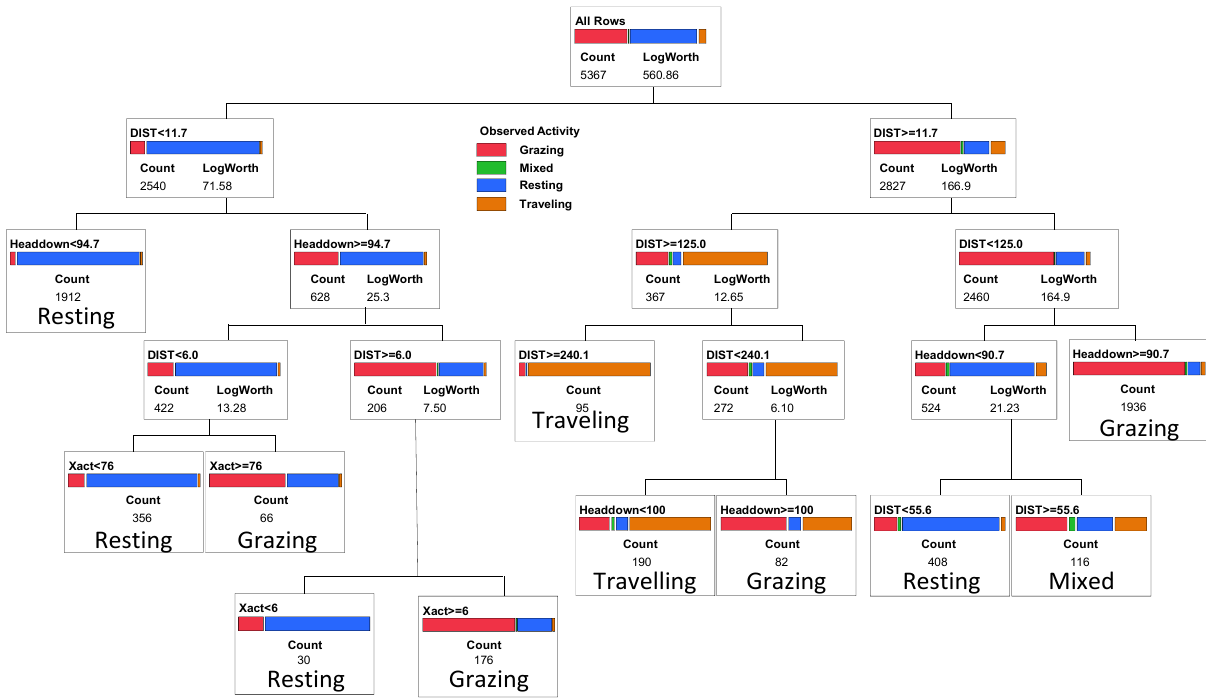
Figure 3. Selected four-category classification tree for cattle activity predicted by movement distances and activity sensor data collected at 5-minute intervals using Lotek 3300LR GPS collars on yearling steers in eastern Colorado. Counts of observations in each box refer to the training dataset used to fit the model. Variables in the classification tree are DIST = Distance in meters between GPS fixes over a 5-minute interval, Xact = number of movements in the X direction detected by the activity sensor, Yact = number of movements in the Y direction detected by the activity sensor, XYsum = Xact + Yact, and Headdown = percent of the 5-minute interval in which the Y-axis sensor was in the head down position. See text for a definition of the LogWorth statistic.